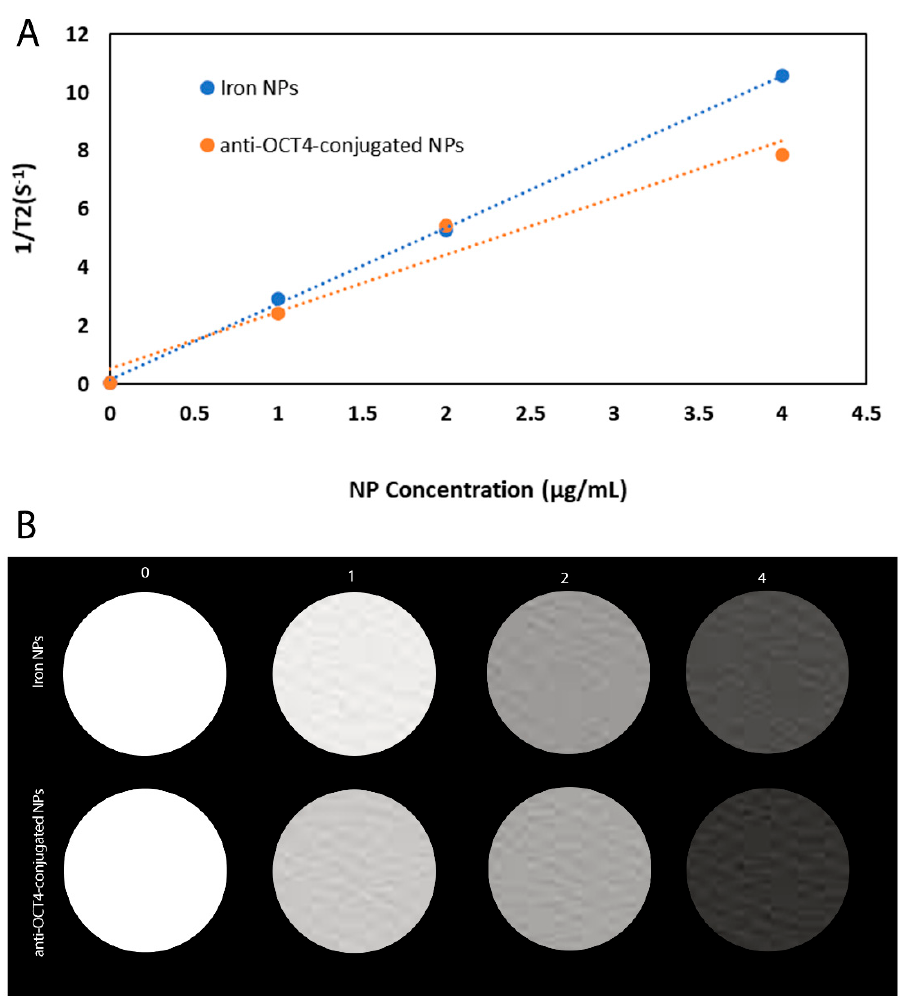
Figure 5. ( A ) Plot of 1/T2 versus NP concentration for iron NPs and anti-Oct4-conjugated NP, ( B ) The respective relaxivity bar diagram for iron NPs and anti-Oct4-conjugated NP.